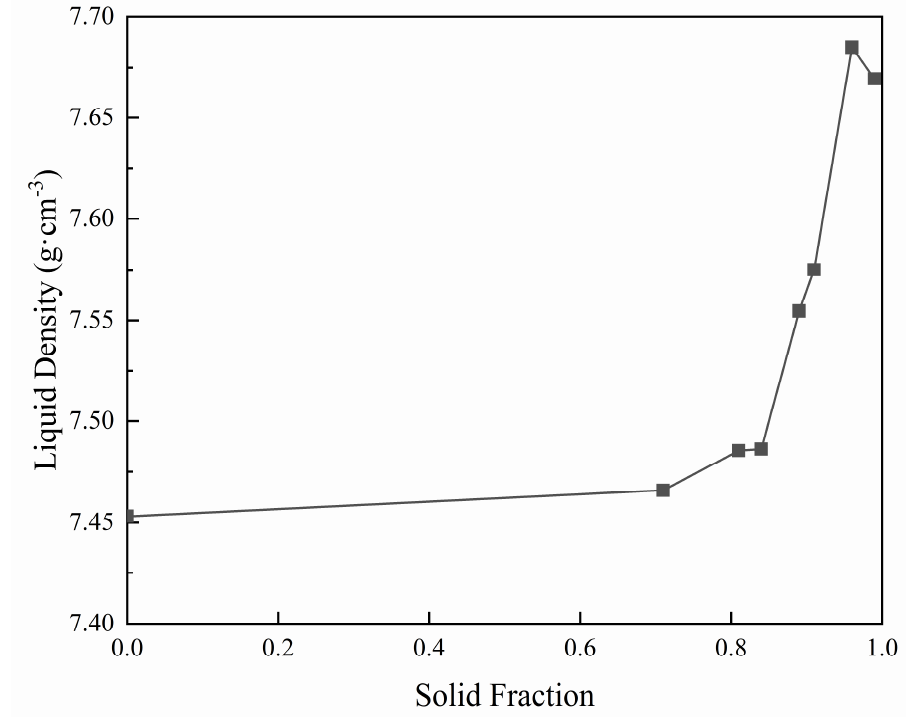
Figure 7. The variation trend of liquid density during solidification.